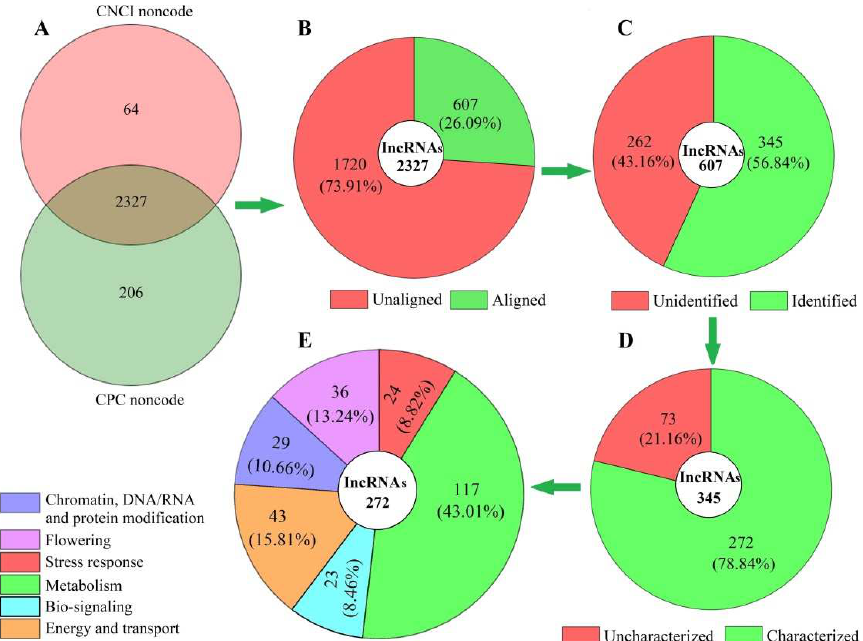
Figure 1. Distribution and classification of lncRNAs in Angelica sinensis during vernalization, based on the biological functions of coexpressed mRNAs. Abbreviations: CNCI, coding–noncoding index; CPC, coding potential calculator. Images ( A ), ( B ), ( C ), ( D ) and ( E ) represent total, aligned, identified, characterized and classified lncRNAs, respectively. Table 2. Twenty-nine lncRNAs linked with chromatin, DNA/RNA, and protein